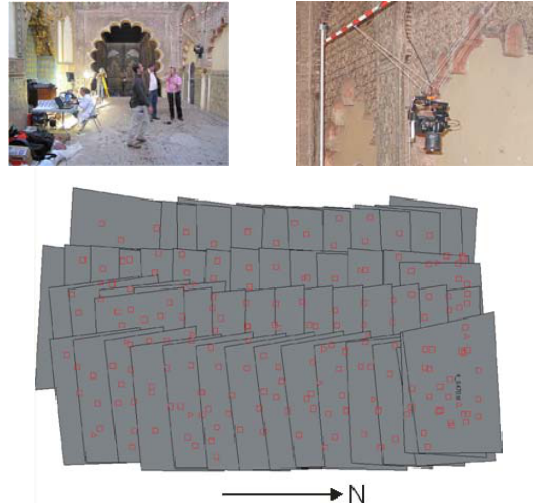
Figure 7. Image acquisition in the floor survey was performed with the help of a Picavet platform. Upper: Details of Picavet platform and acquisition procedure. Lower: Image block geometry with control and tie points measured. Photos are slightly tilted because the large and heavy 20 mm lens tipped back the Picavet platform.